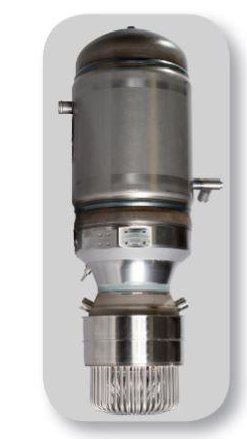
Fig. 6. Stirling engine Qnery PowergGen 1200/5650, power 1.2 kWe/5.65 kWe [15, 16]